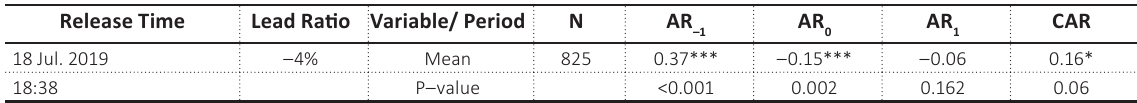
Table 2. Cumulative abnormal returns for the TVBS polls Panel A. CAR for initial